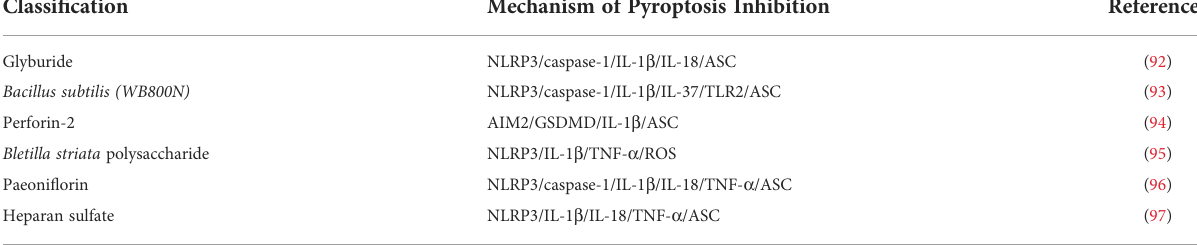
TABLE 1 Compounds or Molecules Inhibiting the Pyroptosis Signaling Pathway for the Treatment and Management of Diabetic Wound. Classi fi